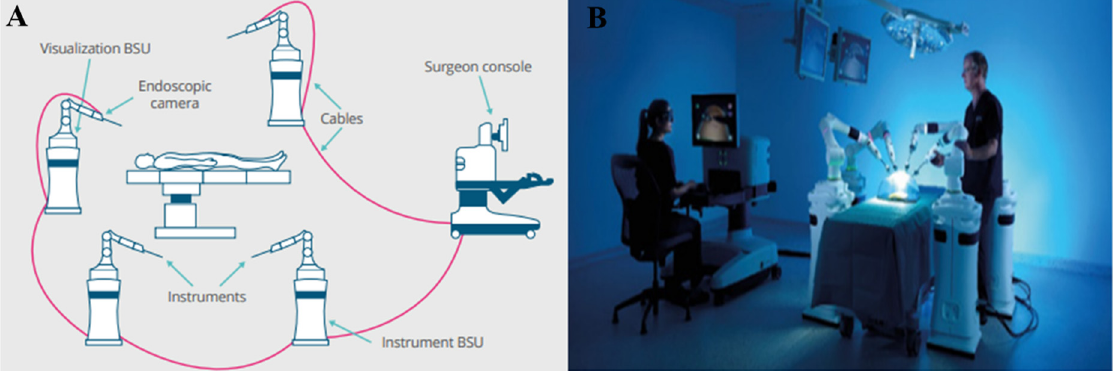
Figure 1. Overview of the Versius surgical robotic system: ( A ) schematic overview of the Versius system and ( B ) the operational set-up image of the Versius system. BSU, bedside unit.